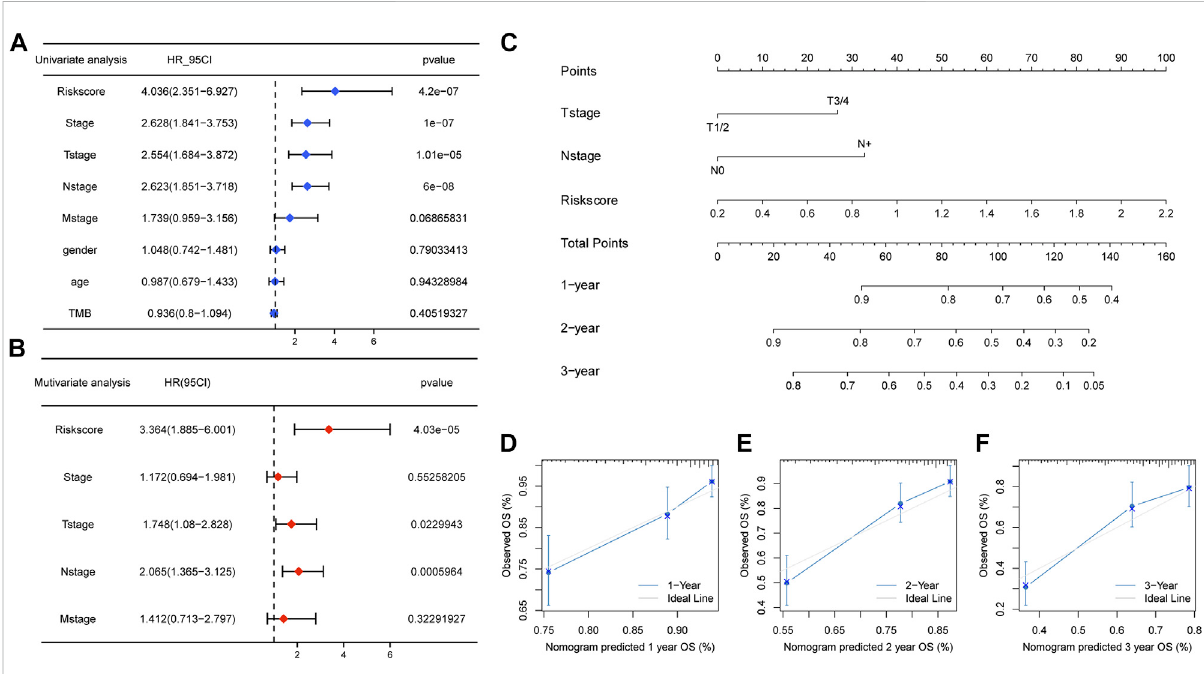
FIGURE 9 Clinicalpredictingmodelbasedontheriskscore. (A,B) UnivariateandmultivariateCoxregressionanalysesfortheriskscoreandclinicalfactors. The risk score, T stage, and N stage were independent prognostic factors for TCGA-LUAD patients. (C) Nomogram predicting for 1-, 2-, and 3-year OS with the independent prognostic factors. (D – F) 1 year, 2 years, and 3 years of calibration plots for the clinical predictive